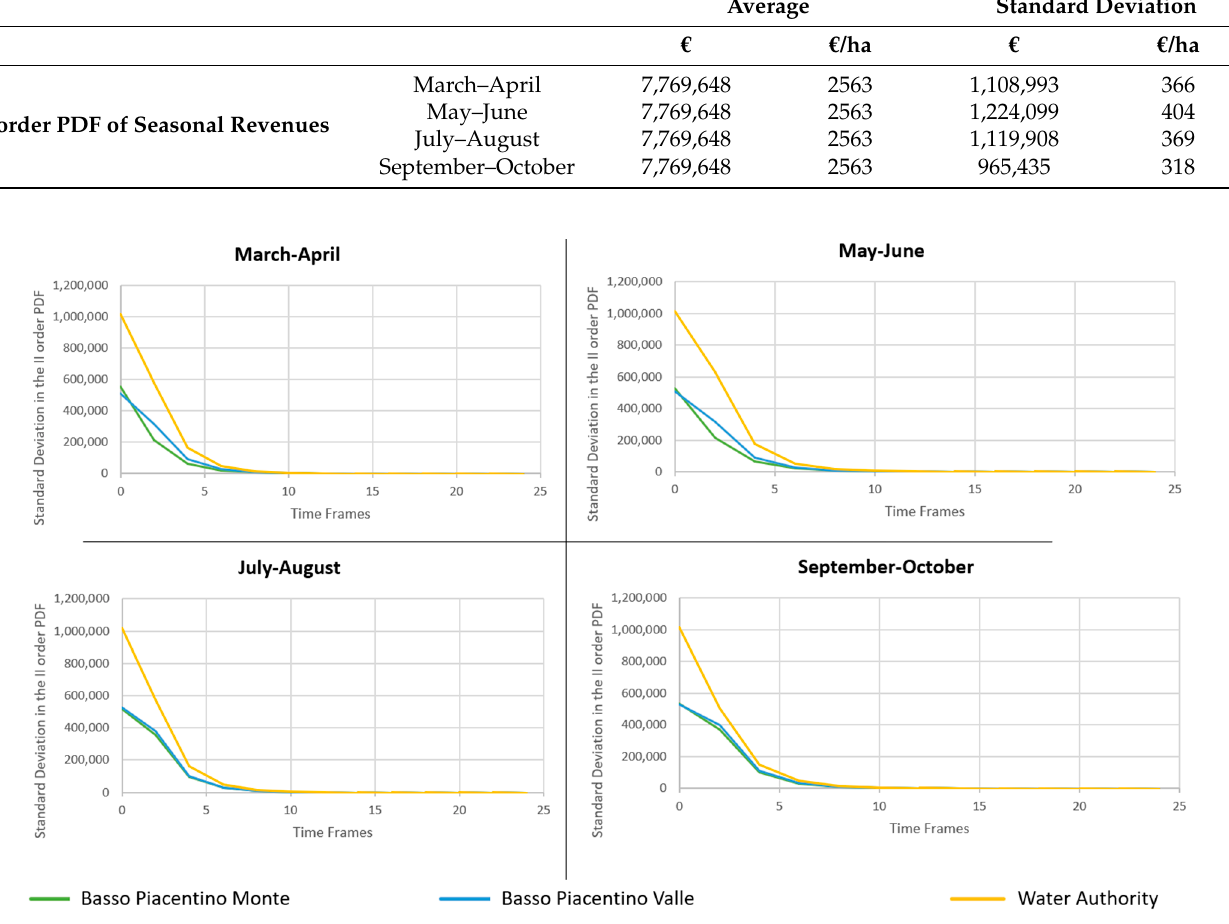
Figure 5. Evolution of standard deviation of the II Order PDF.